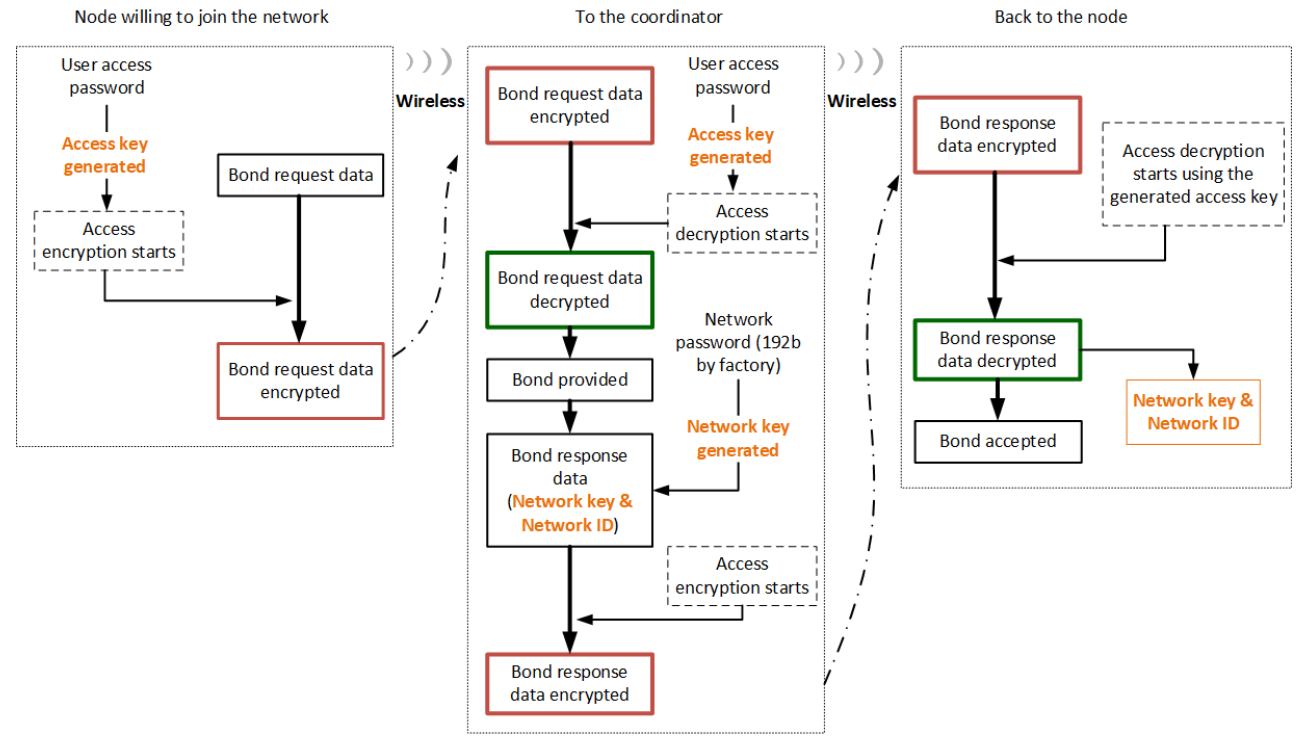
Figure 6. Protection during joining the network process (simplified) https://www.iqrf.org/ technology/security, accessed on 20 October